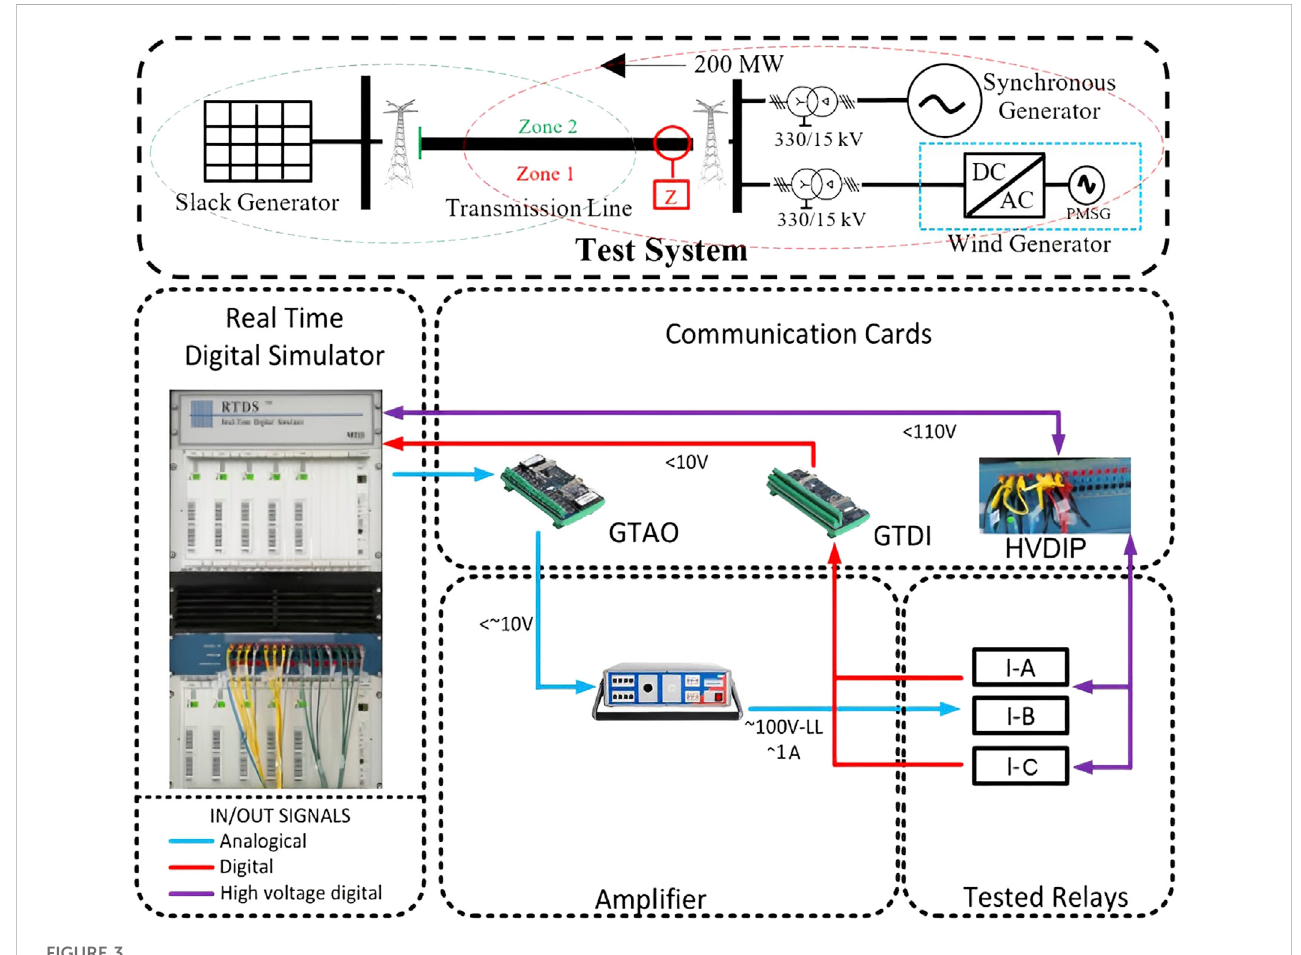
FIGURE 3 Hardware in-the-loop set-up.